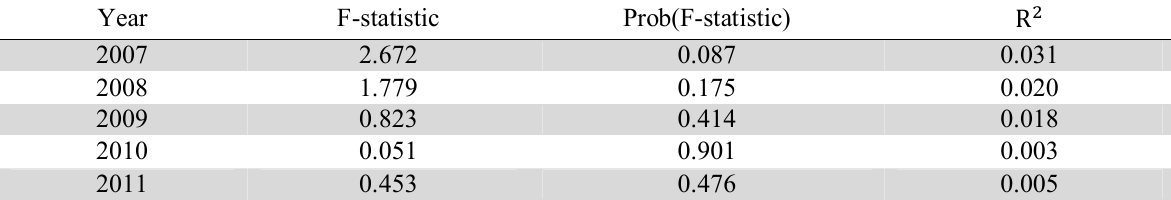
Results of the second hypothesis (H2) significance tests per